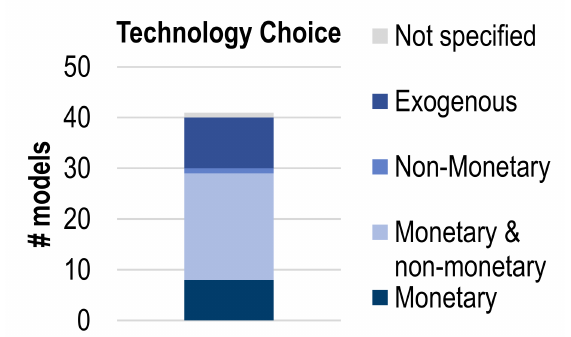
Figure 8. Criteria for vehicle technology